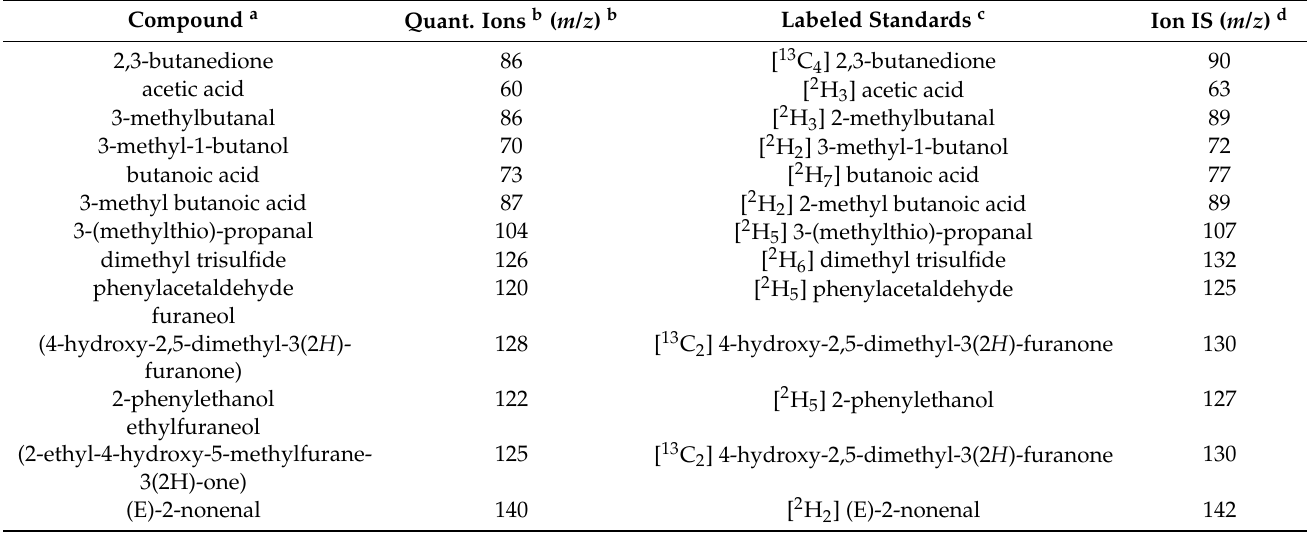
Table 2. Labeled standards and quantitation ions used for SIDA (stable isotope dilution assay) concentration calculations of 13 key odorants present in the post-fermentation